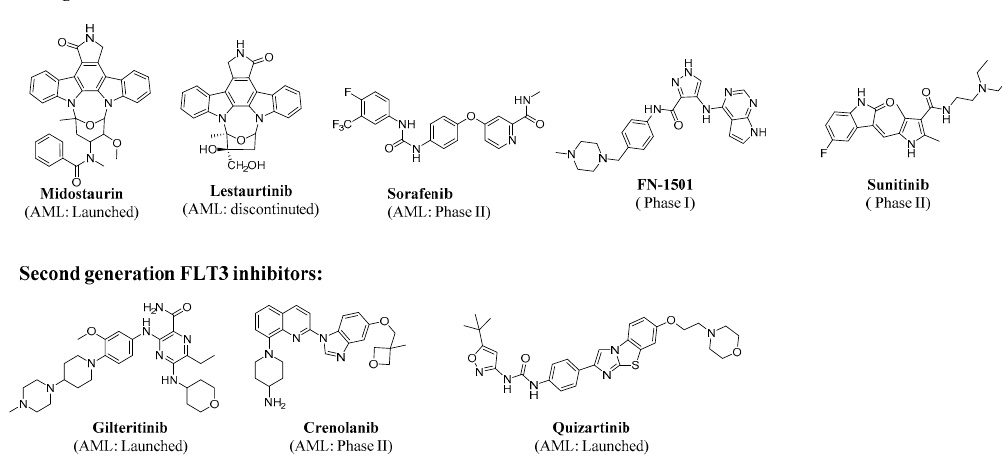
Figure 1. Chemical structures of several Fms-like receptor tyrosine kinase 3 (FLT3) inhibitors in clinical trials for treatment of acute myeloid leukemia (AML). Table 1. FLT3 tyrosine kinase inhibitors under clinical investigation.